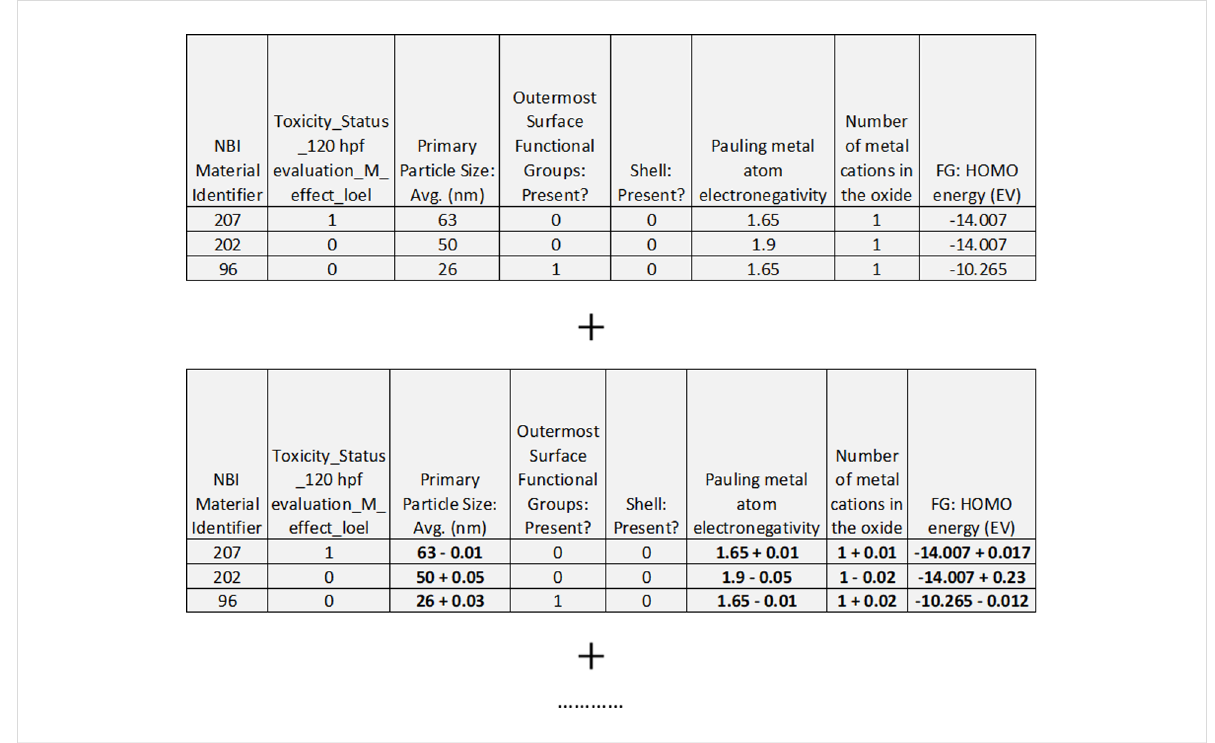
Figure 4: Data augmentation using the “noised training set replication” paradigm. Top: a subset of the available training set ENM samples and the corresponding descriptors is shown. Bottom: the addition of one or more “noised” replicates of the training set, including the perturbation of numeric descriptors using Gaussian noise in bold, is shown.